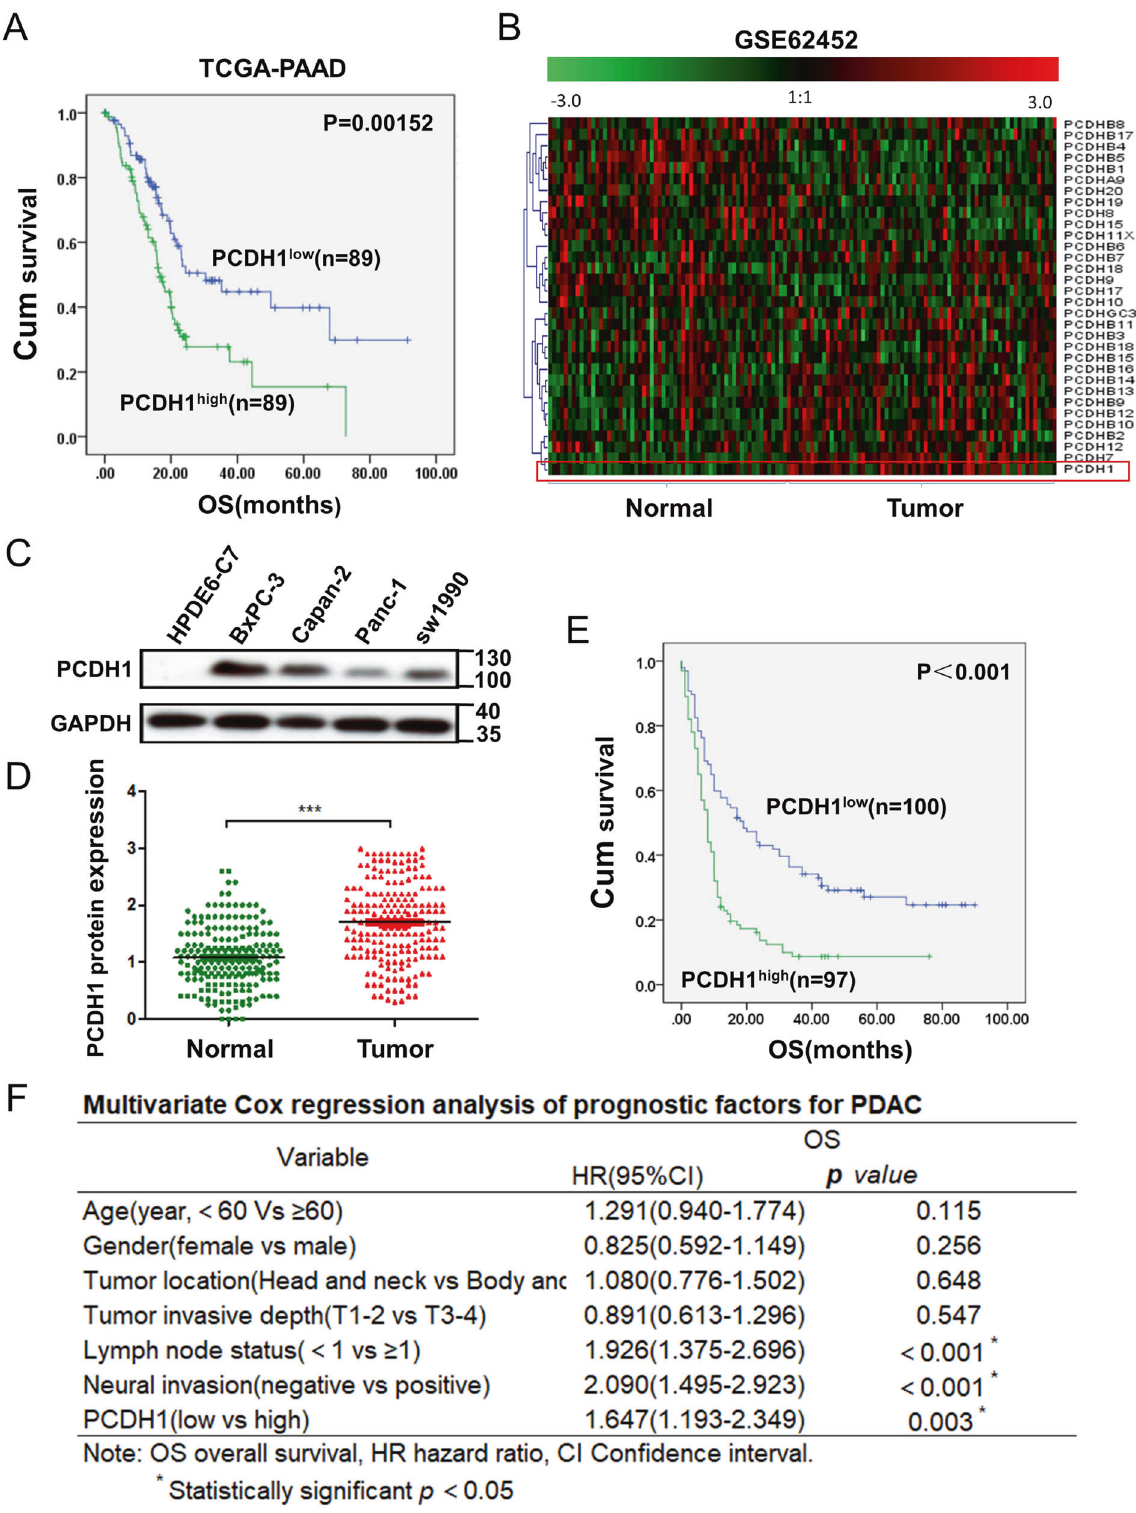
Fig. 1 PCDH1 expression is upregulated in PDAC and predicts poor survival. A High expression of PCDH1 in the TCGA dataset was correlated with worse prognosis in PDAC. B Heatmap of 32 genes of the protocadherin family in PDAC and noncancerous tissues. C In the HPDE6-C7 normal pancreatic ductal epithelial cell line and four PDAC cell lines, the expression of PCDH1 was detected by Western blotting. D Immunohistochemical (IHC) analysis of PCDH1 expression in 197 PDAC tissues and adjacent normal pancreatic tissues. The data were assessed by paired-samples t test. E Kaplan – Meier survival analysis of the correlation between PCDH1 expression and OS (log-rank test). F Multivariate Cox regression analysis of the prognostic factors of PDAC patients. *** P < 0.001.